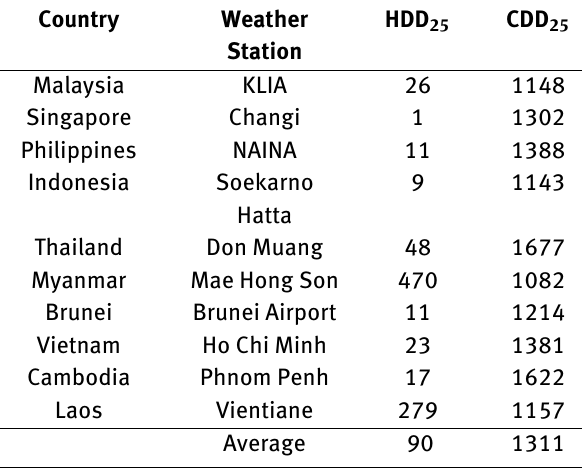
Table 1: Degree-day data for representative SE-Asia cities